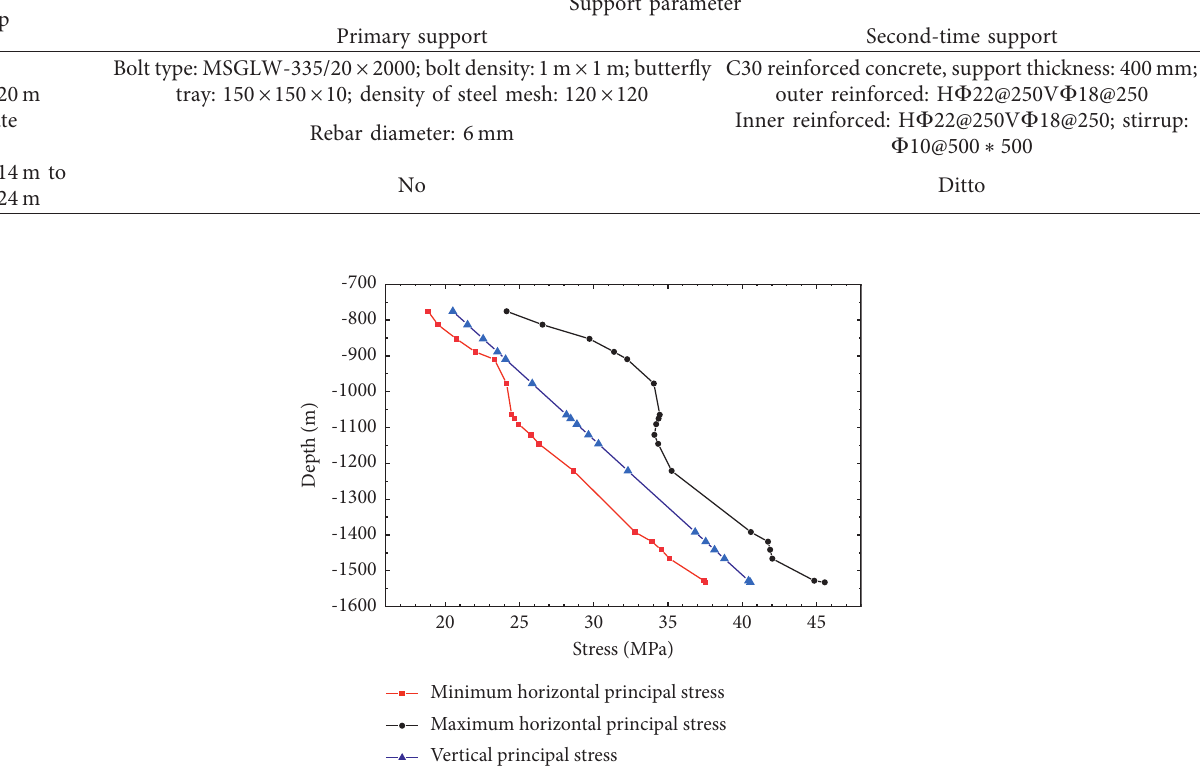
Figure 2: In situ stress distribution of auxiliary shaft in Sha-ling gold